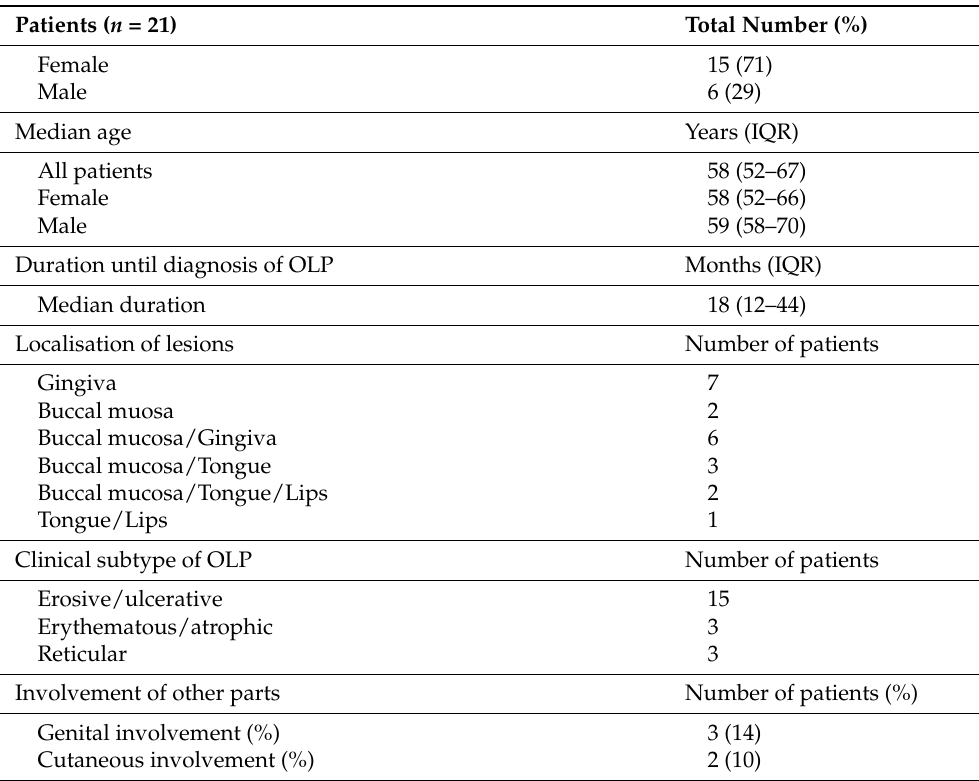
Table 2. Baseline characteristics of all 21 patients. IQR: interquartile range; OLP: oral lichen